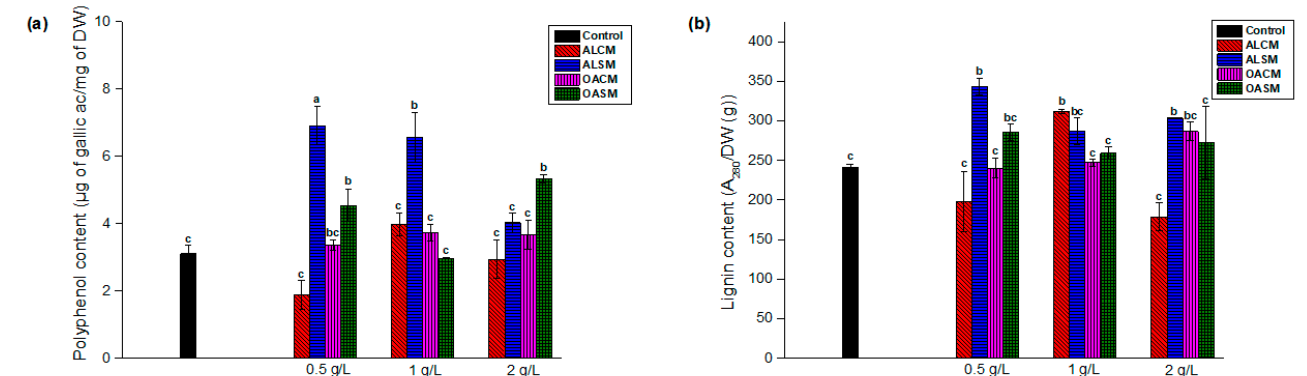
Figure 5. Effect of alginates extracted from CM (ALCM) and SM (ALSM) and their derivatives (OACM and OASM) on the induction of polyphenol ( a ) and lignin ( b ) contents in the leaves of olive tree after 24 h of treatment. The letters (a, b, c) indicate significant differences between treatments at each concentration using the Tukey-HSD test, at ( p < 0.05). Treatments presented with the same letter are not significantly different.